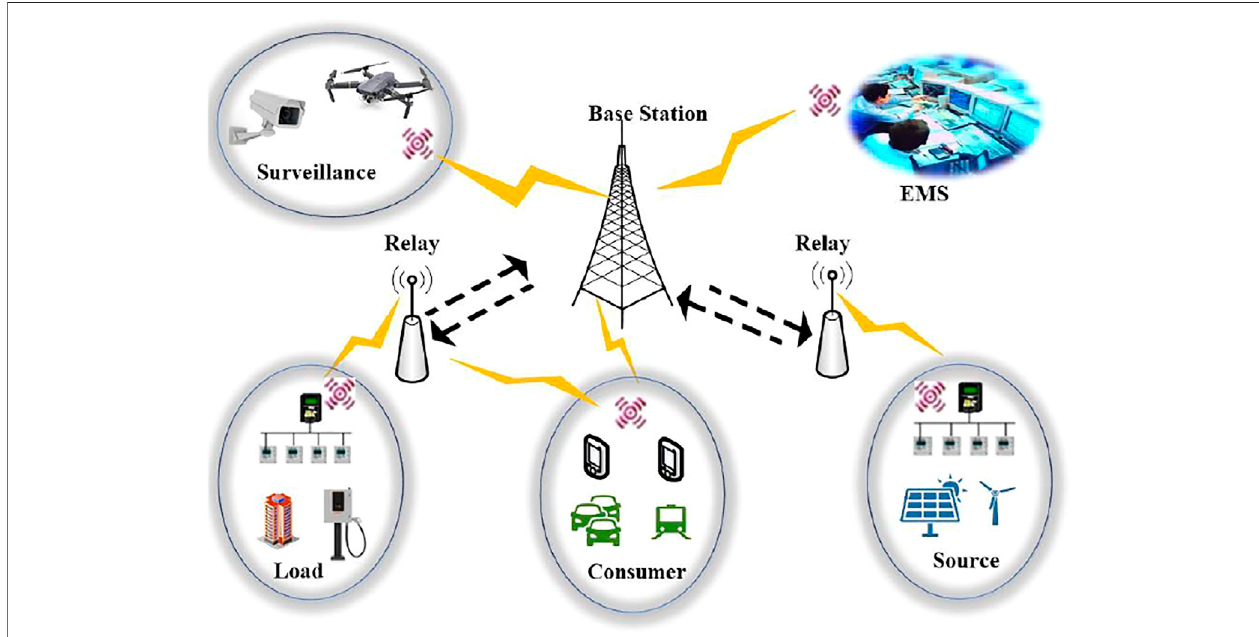
FIGURE 1 | Architecture of an energy Internet communication